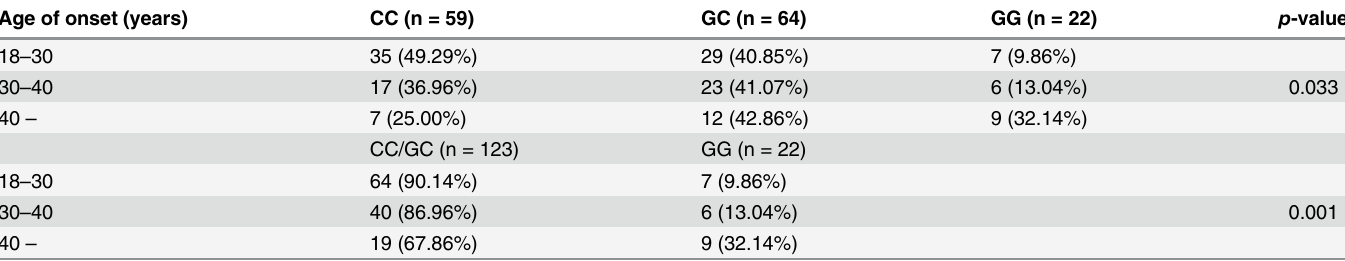
Table 4. The proportion of IgAN patients who were grouped as co-dominant model and recessive model for different age groups. Age of onset (years) CC (n =